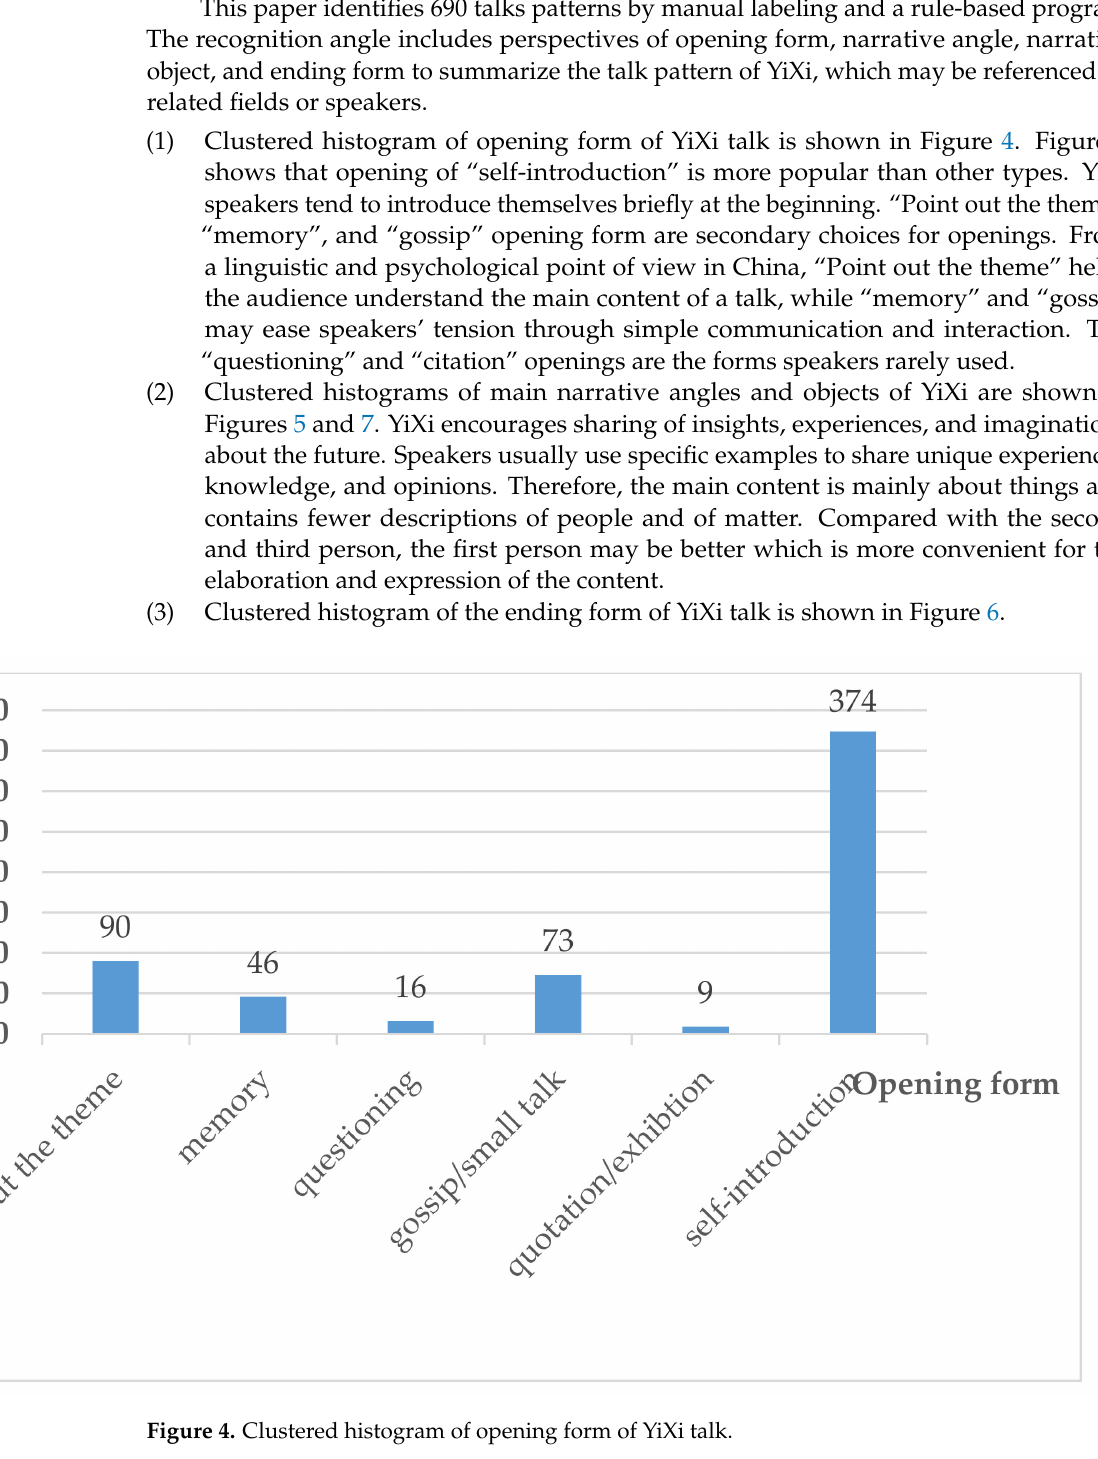
Figure 4. Clustered histogram of opening form of YiXi